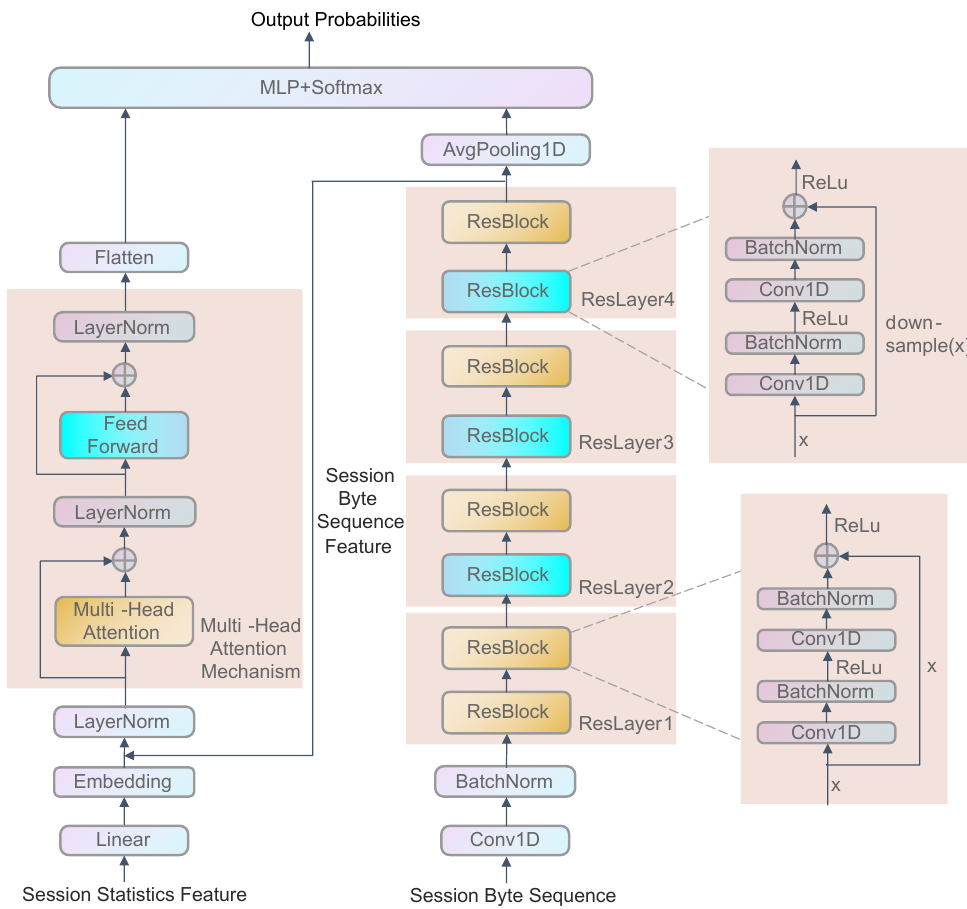
Figure 3. Structure of